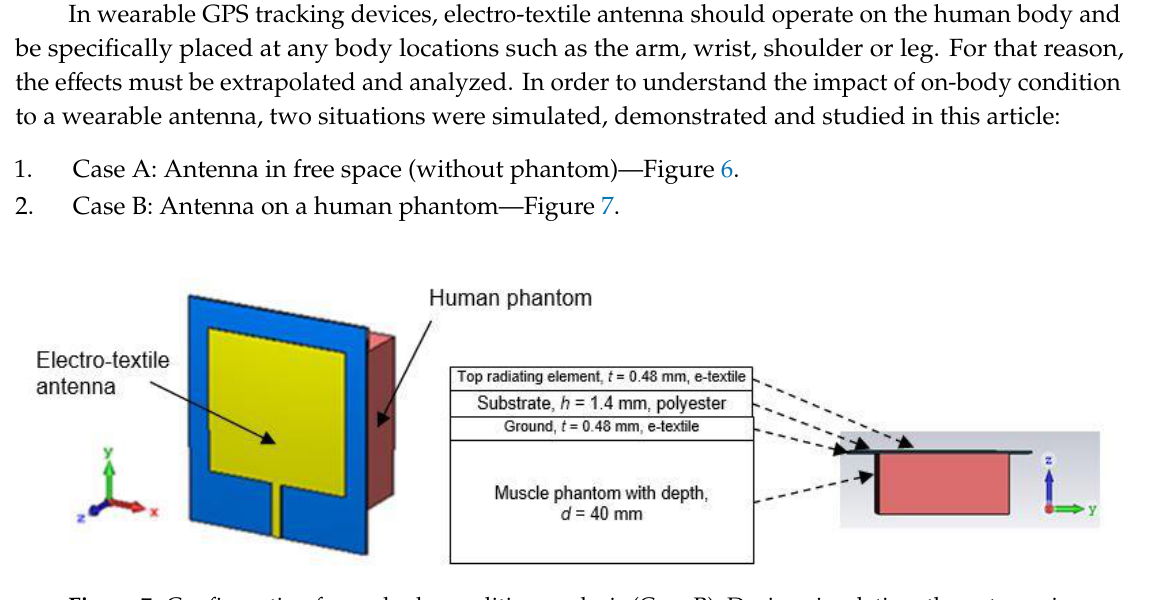
Figure 6. Geometry and structure of 1.575 GHz rectangular electro-textile antenna in the free space condition (Case A), with W/L ratio of 1.1 for the conductive layer and W s /L s ratio of 0.9 for the non-conductive layer. These values have been optimized based on the free space condition.